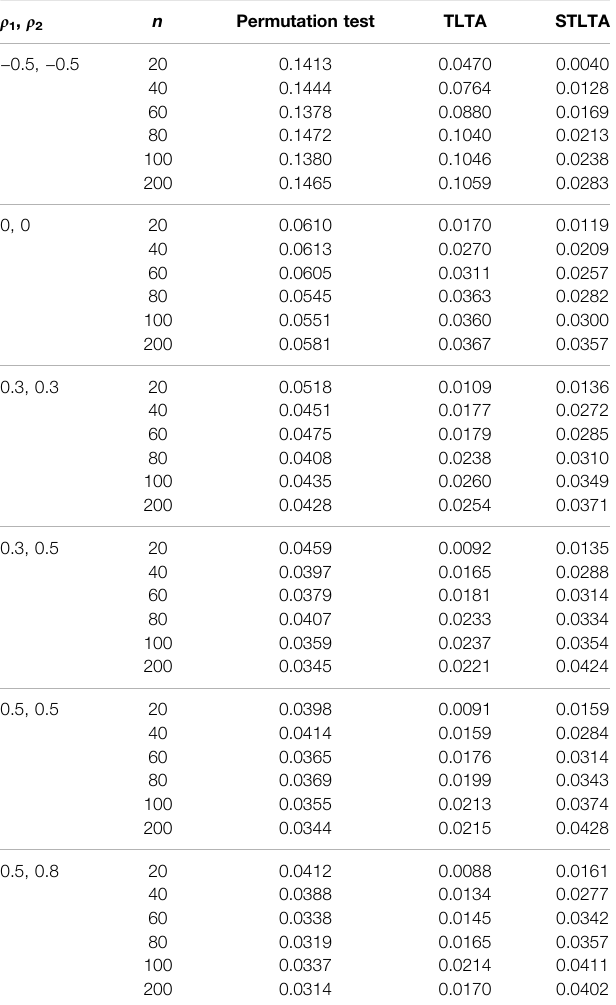
TABLE 2 | Type I error rate for different methods (the third to fi fth columns) in the ARMA(1,1)modelwhen t =0.The fi rstandsecondcolumnsrepresentdifferent combinations of autoregressive coef fi cients and sample sizes. The number of permutation tests is 1,000, the number ofrepeated simulations is 10,000, and the signi fi cance level is α =